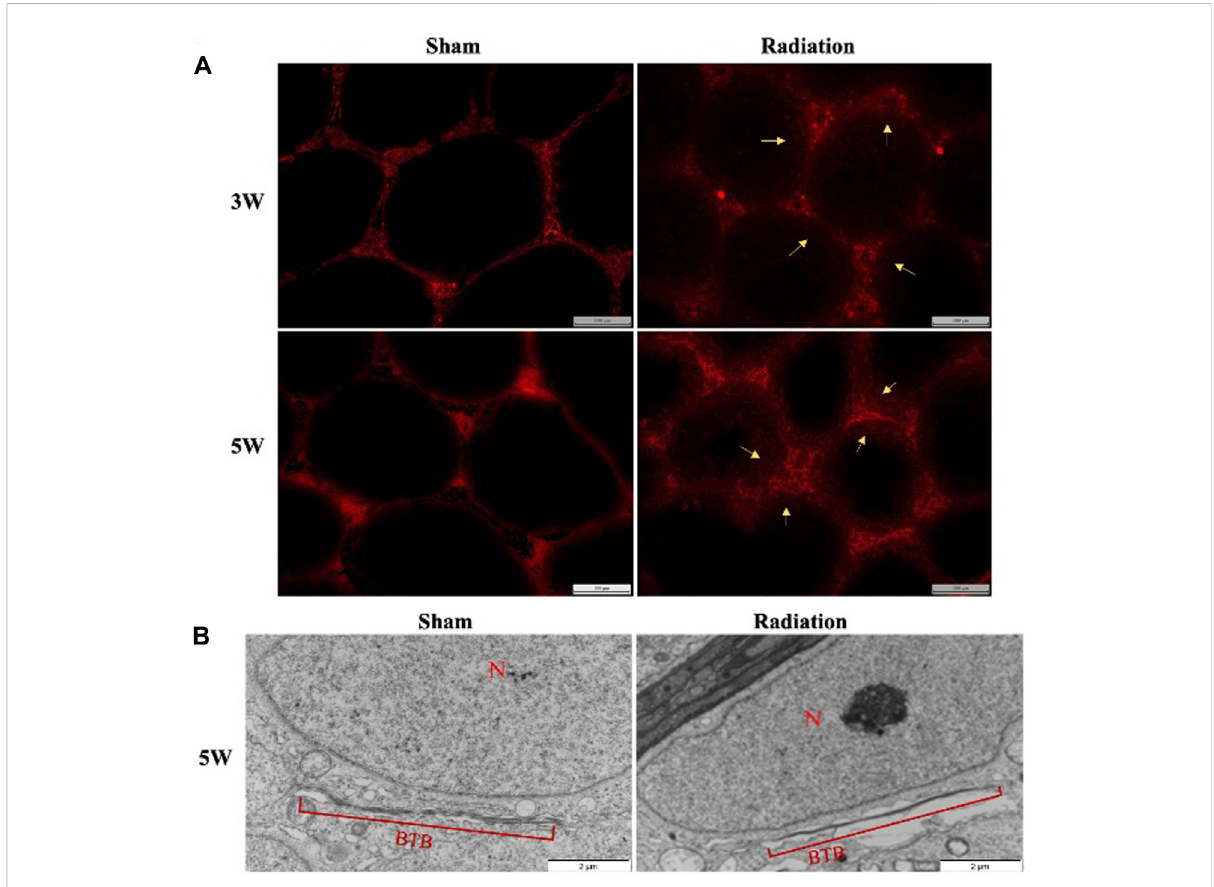
FIGURE 6 Abscopal effects of thoracic X-ray irradiation on the permeability of BTB in mice. (A) Detection of BTB permeability by EB fl uorescence chromogenicassay,Bar=100 μ m(200×), n =4foreachgroup. (B) TEMobservationofBTB,Bar=100 μ m,N:nucleus;BTB:blood-testisbarrier, n = 3 for each group. The values are expressed as the mean ± SD, * p < 0.01; ** p < 0.01; *** p < 0.001 vs. sham